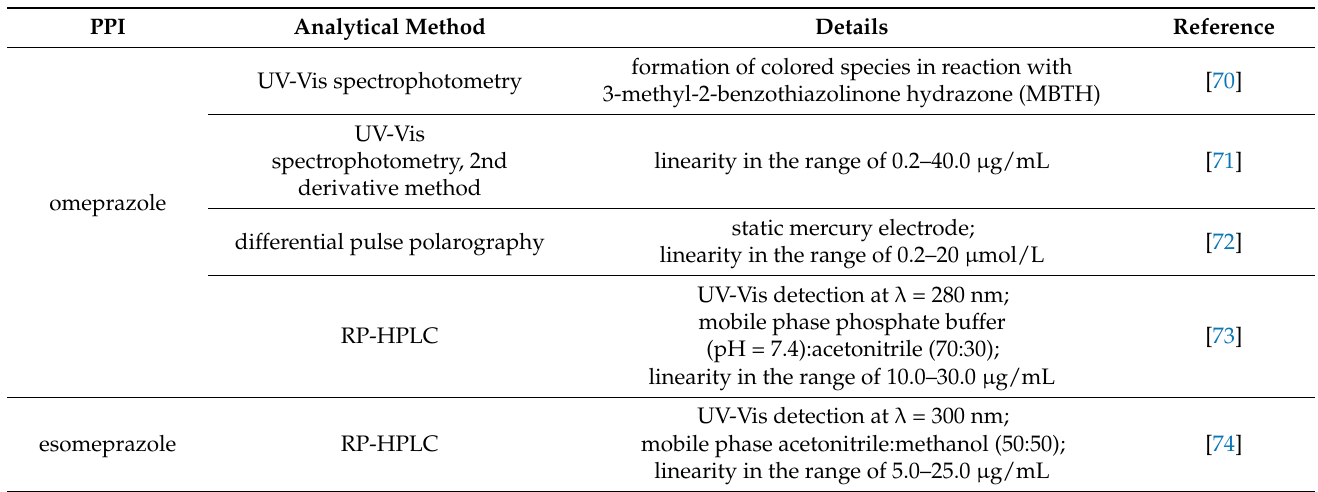
Table 2. Examples of analytical methods for PPIs determination.